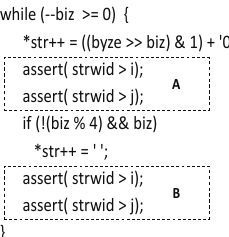
Figure 1. An example of